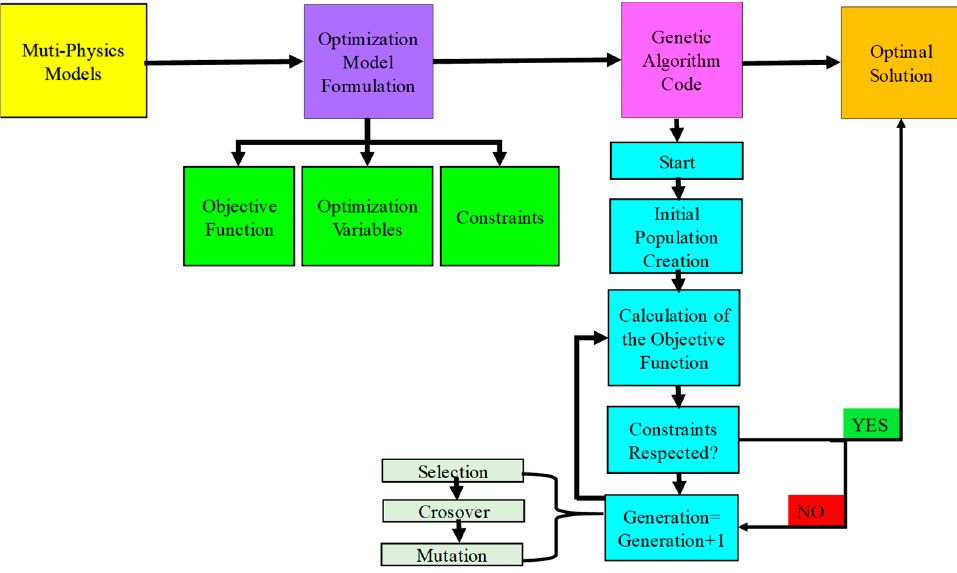
Figure 4. Steps of the design by optimization approach using the genetic algorithm method.